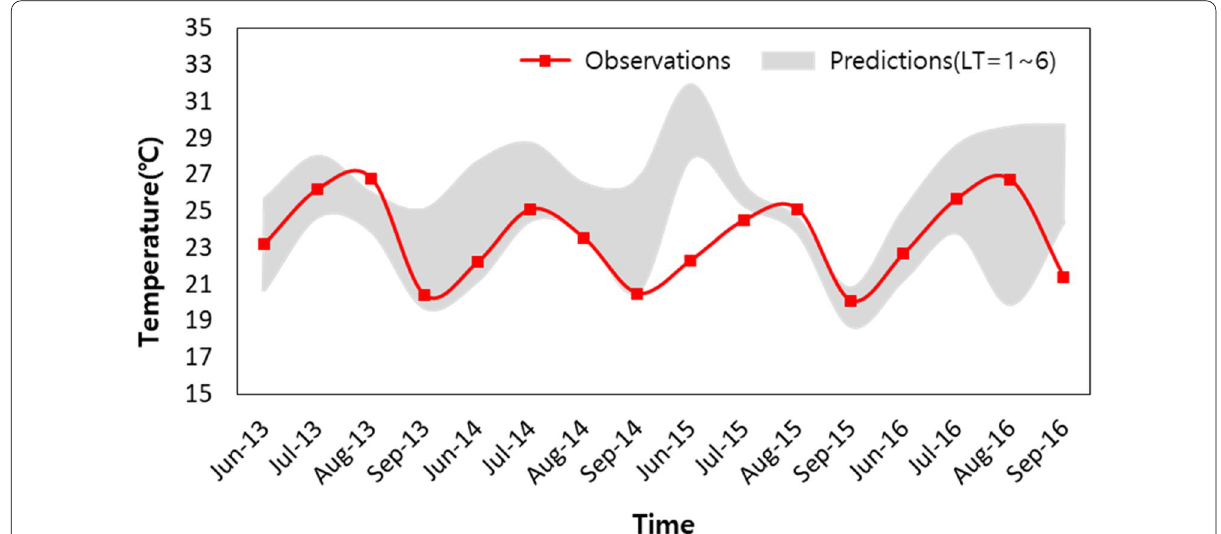
Fig. 9 Results of the modified temperature prediction